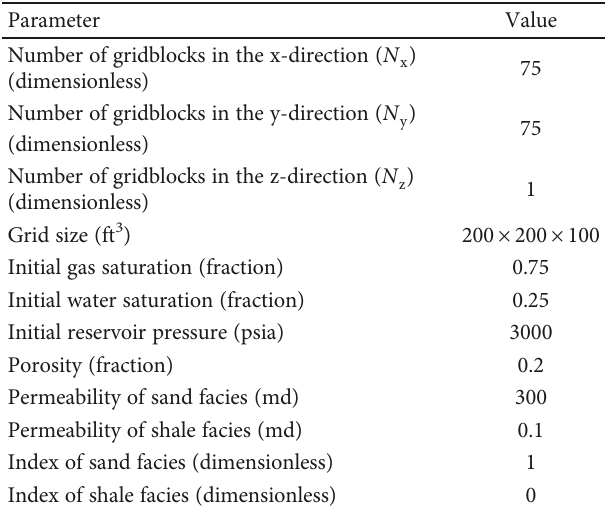
Table 2: Experimental setting of reservoir parameters used in Case 1 and Case